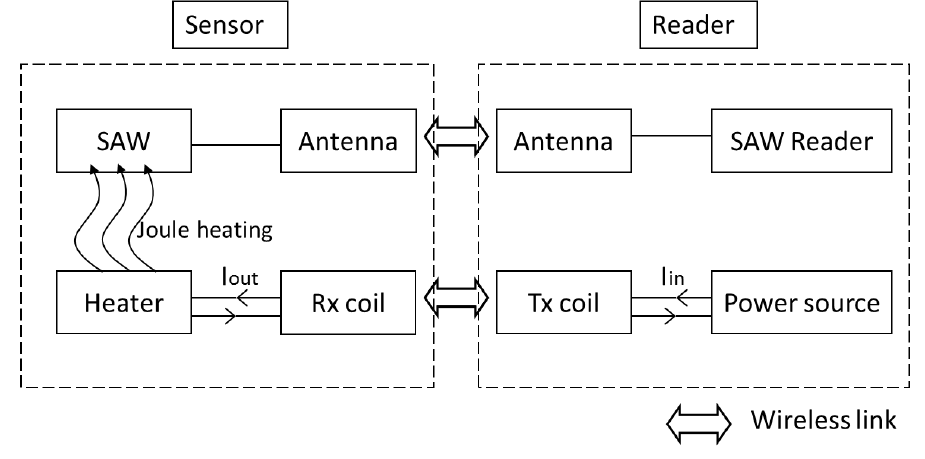
Figure 3. Schematics of the whole WiPirani system, including the WiPirani sensor and its